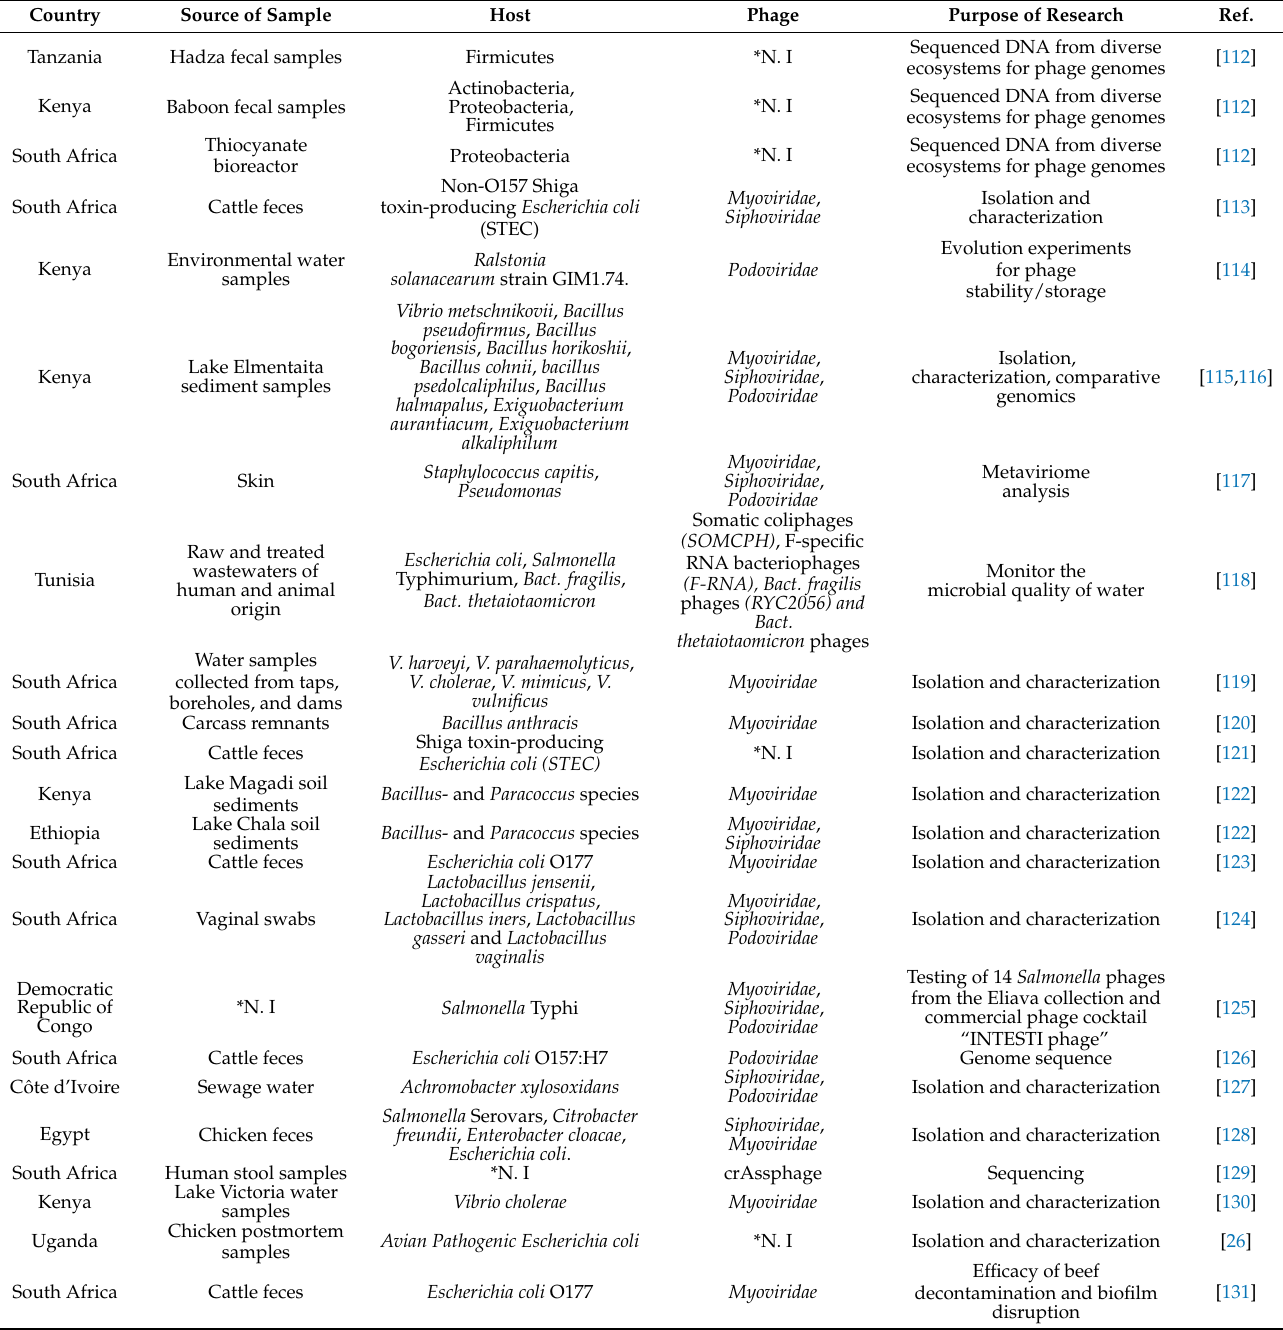
Table 2. Representation of phage research in Africa over a decade